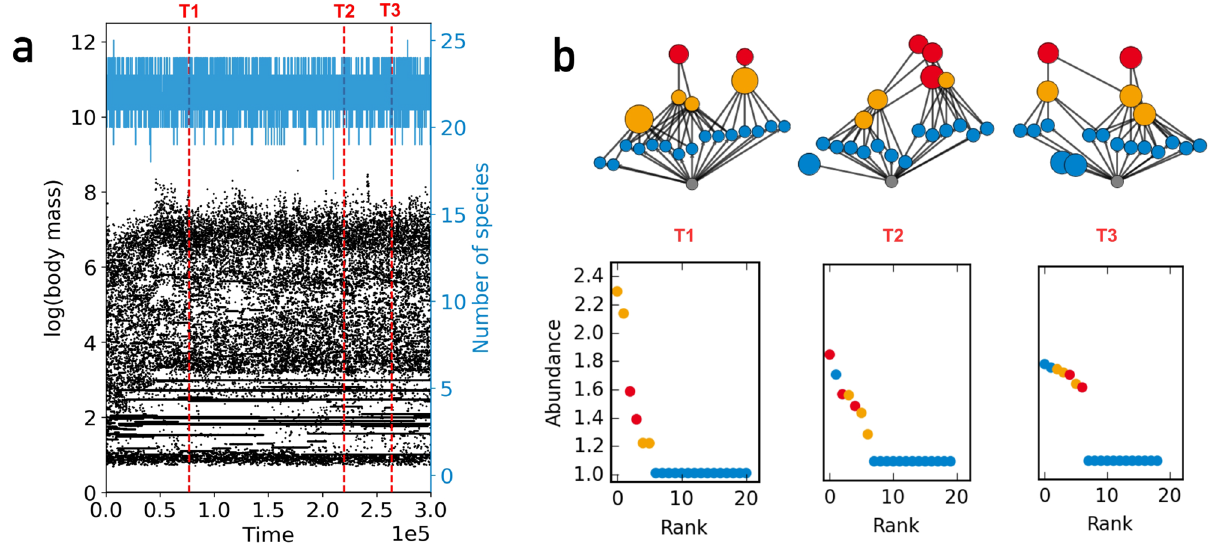
Figure 2. ( a ) Time series for one habitat out of a grid of 10 × 10 habitats. At each time point the body masses of all species present at this habitat are plotted. The blue curve denotes species number in this habitat. ( b ) Food web structure and rank abundance curves for the three time points indicated in ( a ) by dashed vertical lines. Rank is determined by sorting species for their abundance. This results in the most abundant species having the smallest rank. Colors indicate trophic level (blue = basal, yellow = intermediate, red =